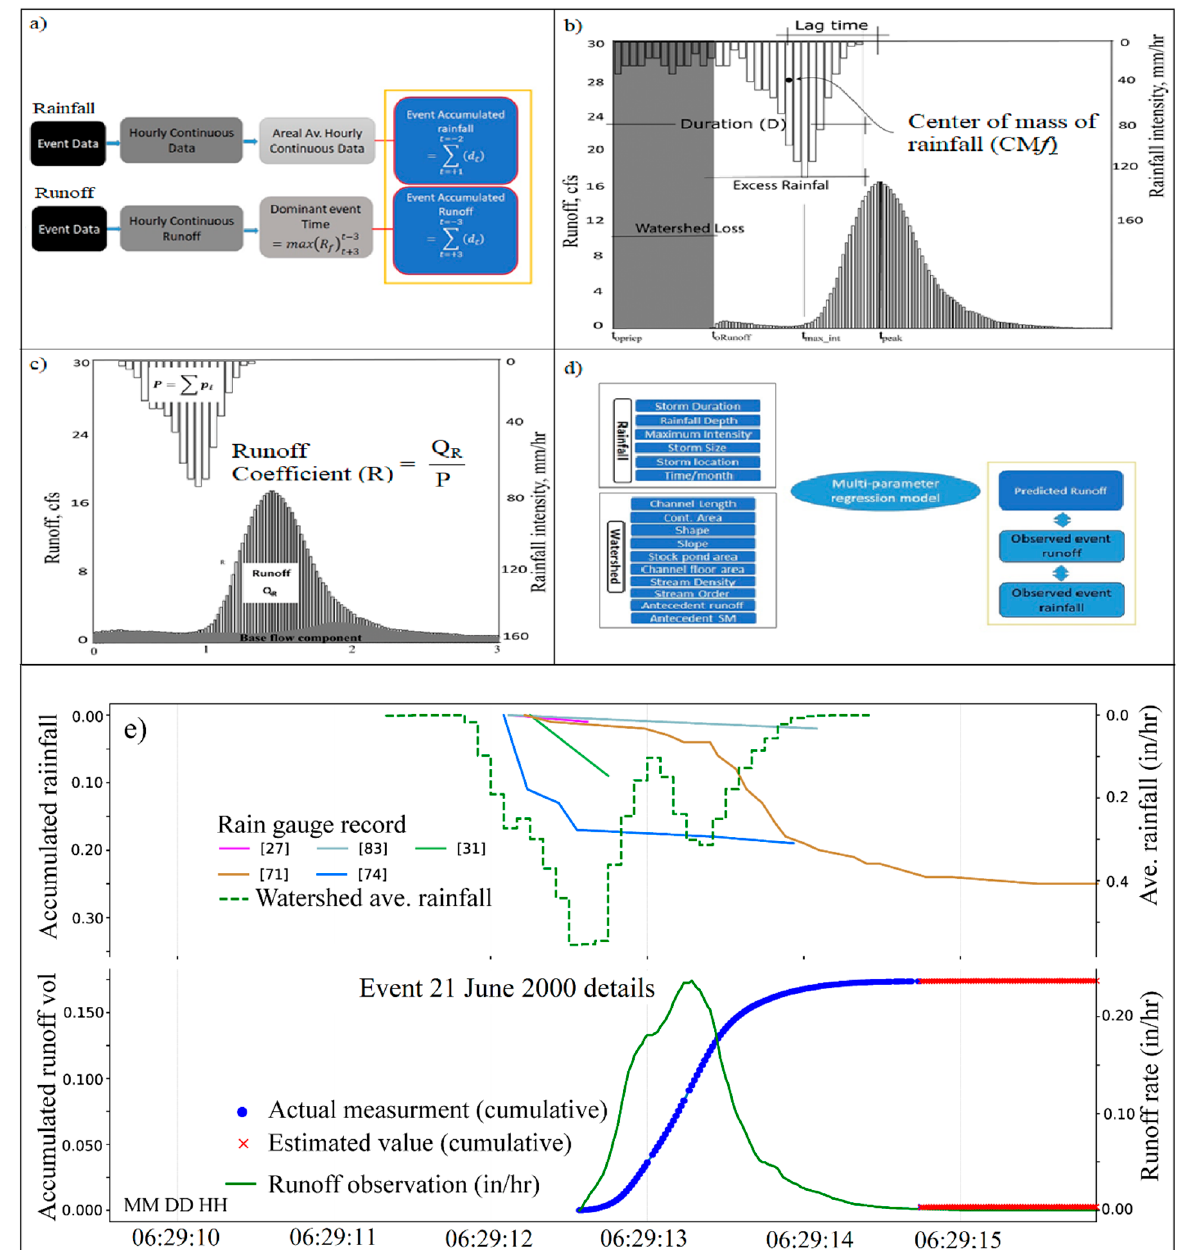
Figure 3. Schematic description of the five approaches used for runoff quality assurance and quality control (QAQC). ( a ) Rainfall-runoff association method, ( b ) Lag time, ( c ) Runoff coefficient, ( d ) Regression method, and ( e ) plots of runoff and corresponding rainfall. The red “x” represents the estimated runoff rate when hydrograph recordings are truncated from the long tail baseflow due to the stilling basin’s siltation.